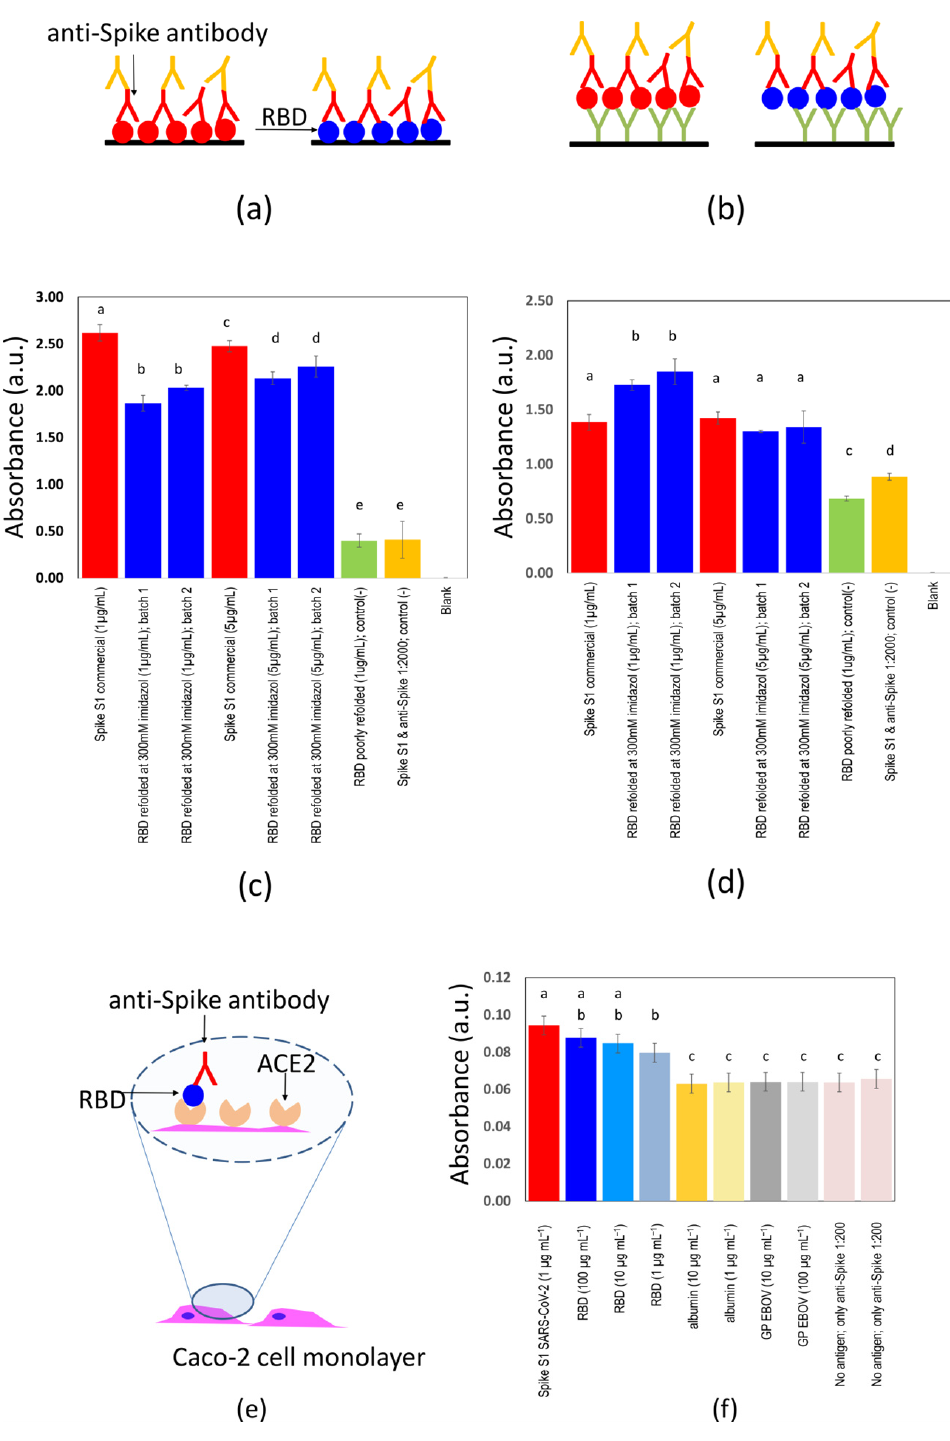
Figure 2 Figure 2. Contrast of two versions of ELISAs for identification of anti-spike SARS-CoV-2 antibodies. Comparison of a commercial full-length spike protein from SARS-CoV-2 (red circles) and the S-RBD N318-V510 protein (blue circles) produced in Escherichia coli as antigens in ELISA experiments performed to identify anti-spike SARS-CoV-2 antibodies. The antigen was ( a ) directly bound to the surface of 96-well plates, or ( b ) bound through a layer of anti-histidine antibodies (red Ys). In both cases, the specific attachment of anti-spike SARS-CoV-2 antibodies (blue Ys) was revealed by binding of anti-human heavy-chain antibodies functionalized with horseradish peroxidase (yellow Ys). Comparison of absorbance readings for ( c ) direct ELISAs or ( d ) anti-histidine-mediated ELISAs. A commercial full-length spike (red bars) or the S-RBD N318-V510 protein (blue bars) was used as the antigen. Commercially available anti-spike SARS-CoV-2 antibodies were used as reactants. Negative controls consisted of the S-RBD N318-V510 protein either deficiently folded in glycerol and phosphate-buffered